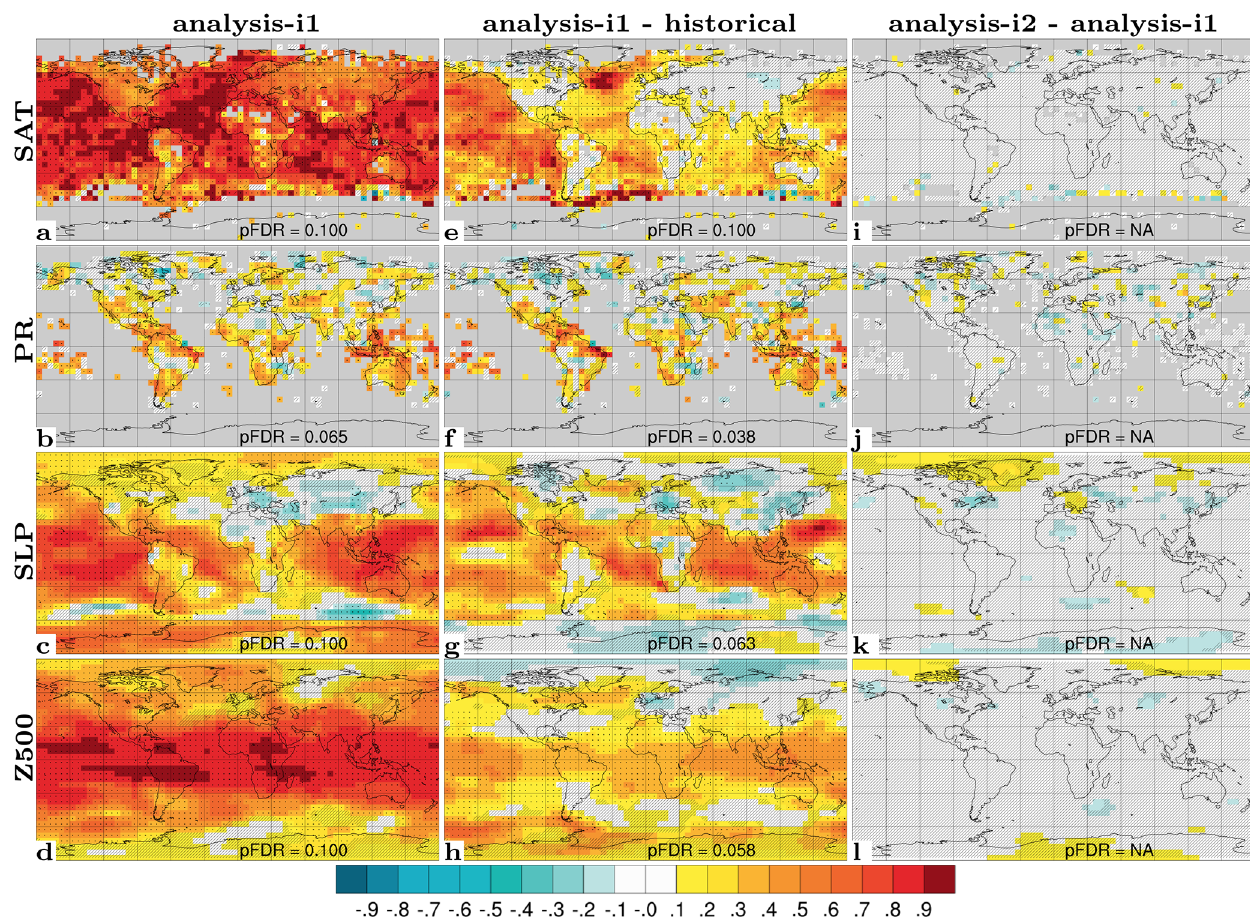
Figure 10. ACC for annual 2m temperature (SAT, a ), precipitation (PR, b ), sea level pressure (SLP, c ) and 500hPa geopotential height ( Z 500, d ) for assim-i1 . (cid:49) ACC for assim-i1 – historical (e–h) , assim-i2 – assim-i1 (i–l) . Temporal coverage is 1950–2018 for observed SAT (HadCRUT4; Morice et al., 2012), PR (CRU TS4.03; Harris et al., 2020), SLP (NCEP reanalysis; Kalnay et al., 1996) and Z 500 (extended ERA5; Harris et al., 2020). Hatched areas are not locally significant; dotted areas are field